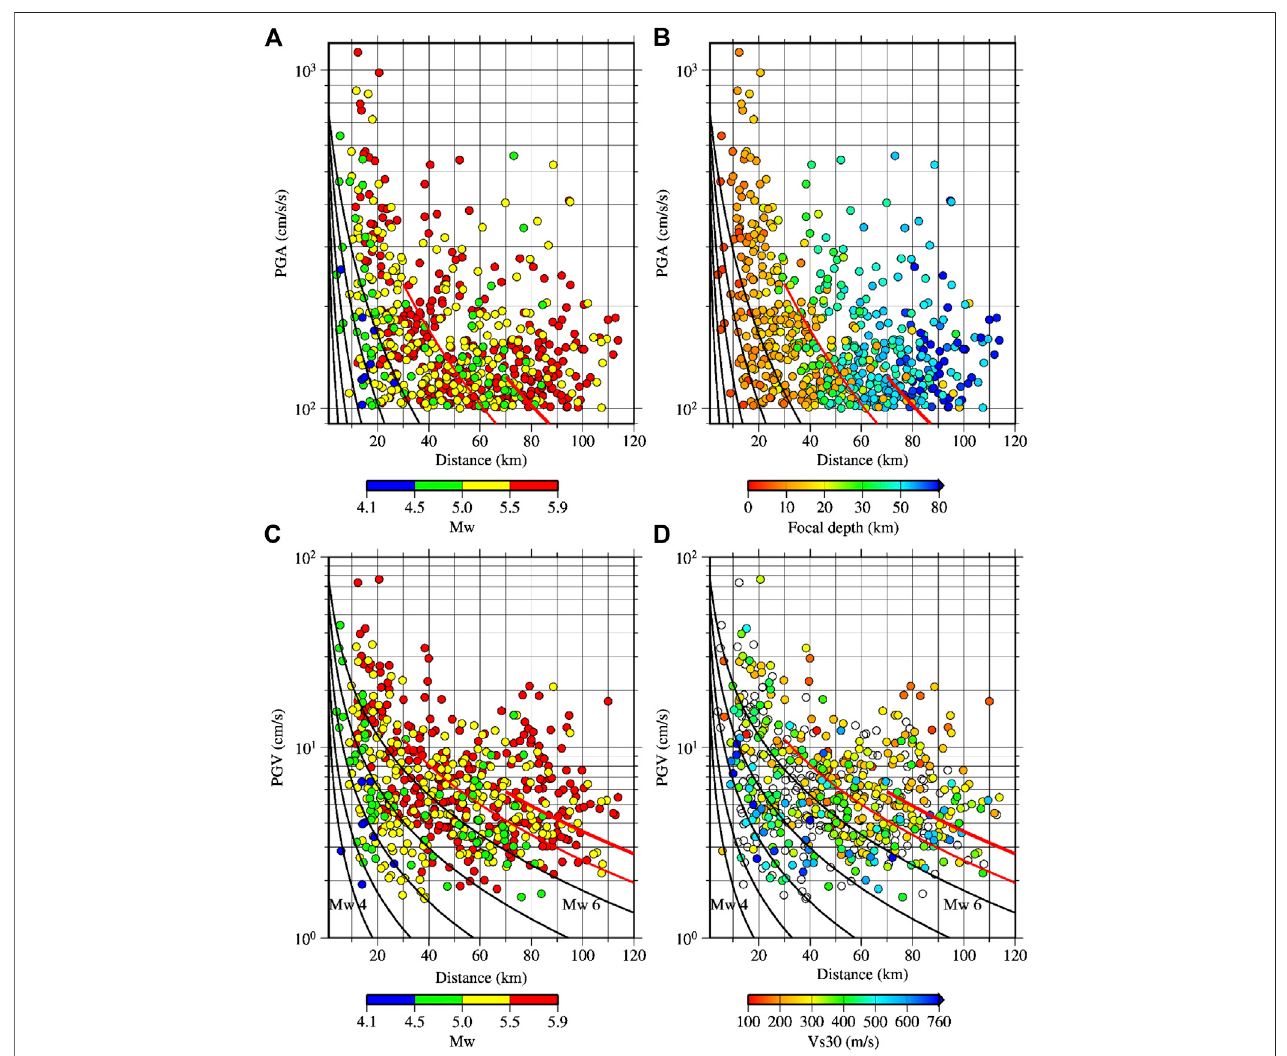
FIGURE 4 | (A,B) : same plot as in Figure 3A , but the PGA values smaller than 100 cm/s/s are not shown, and the hypocentral distance is limited to 120 km. The datain (A) arecolor-codedbymagnitudewhiledatainbbyfocaldepths. (C,D) :similar to (A,B) ,but forthePGVs.Thedataarecolor-codedbymagnitudesin (C) andby Vs30 in (D) . Open circles show data lacking Vs30 values. The black curved lines denote theprediction curvesin the same order, as plotted in Figure 3 . Thered thin and thick lines denote the median prediction curves for intraslab earthquakes of focal depths 30 and 70 km, respectively, for Mw (cid:2) 6. The prediction curves were obtained using the GMPEs in Si and Midorikawa